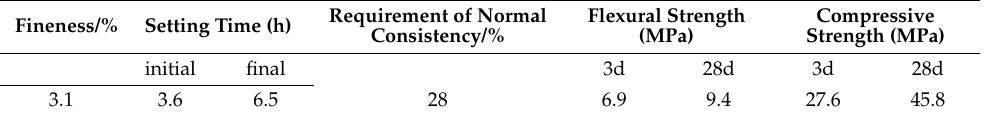
Table 7. Technical properties of cement.